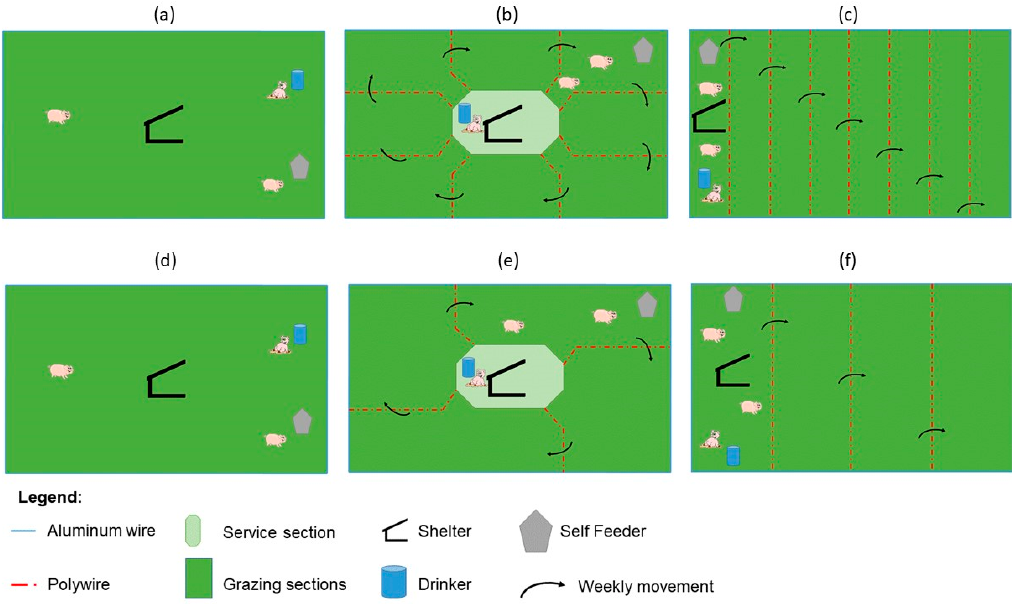
Figure 2. Stocking methods under comparison, weeks 1 to 8: ( a ) Continuous, ( b ) Rotational and ( c ) Strip-grazing. Weeks 9 to 12: ( d ) Continuous, ( e ) Rotational and ( f ) Strip-grazing. Figures ( d – f ) represent figures ( a – c ) following removal of certain fences and grazed four additional weeks.